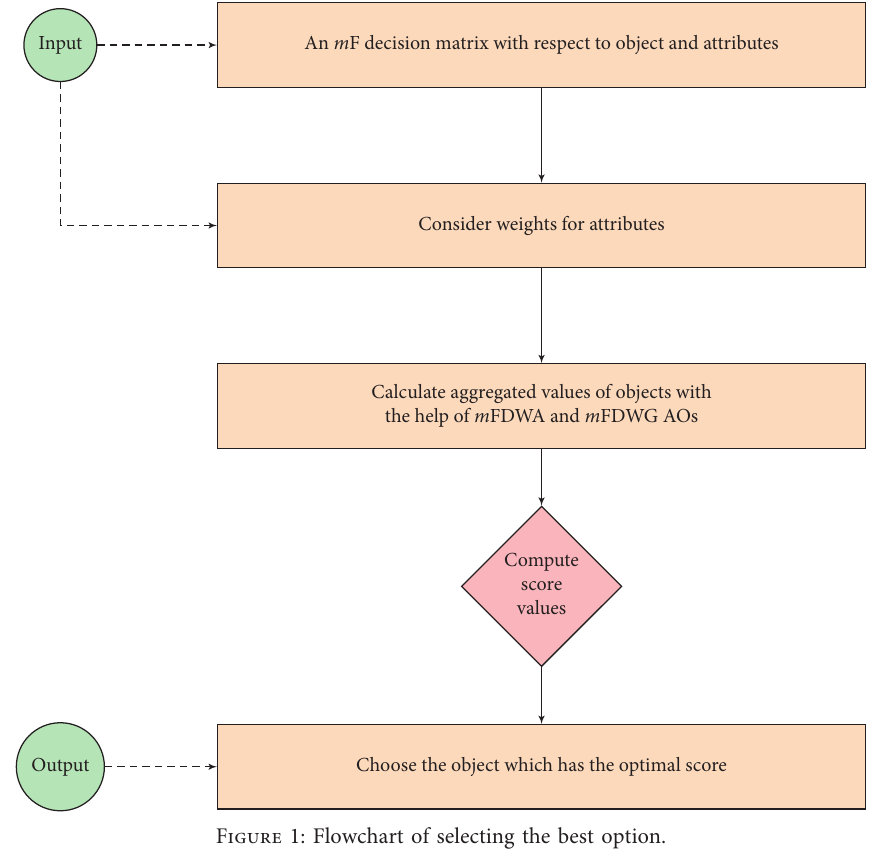
Figure 1: Flowchart of selecting the best option.